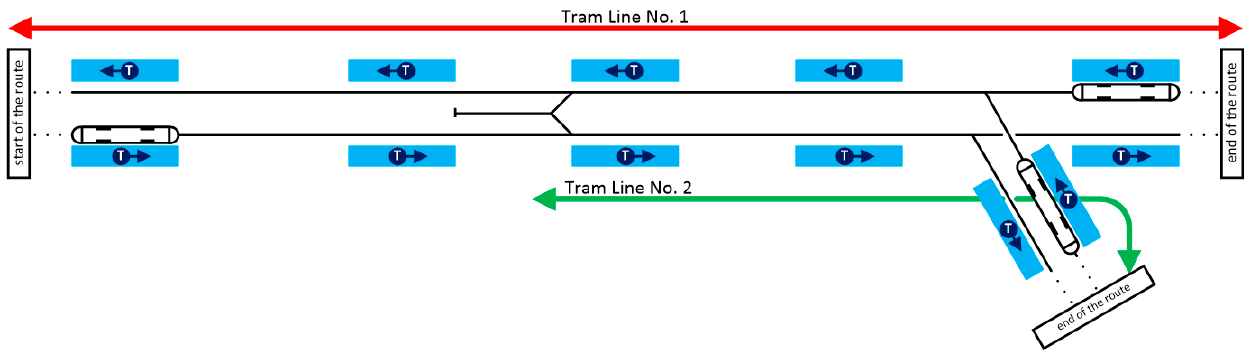
Figure 10. Using the bi-directional tram to diversify the routing of the two sample tram lines on the shared section of the route.